Question: Give a one-sentence summary of this figure.
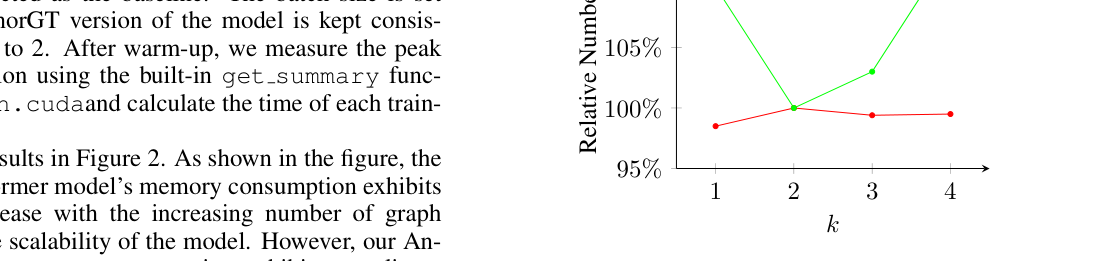
Answer: Relative Performance and Memory Cost (%) of GraphGPS-AnchorGT-SPD on qm9 dataset. The settings stay the same with Table 2.